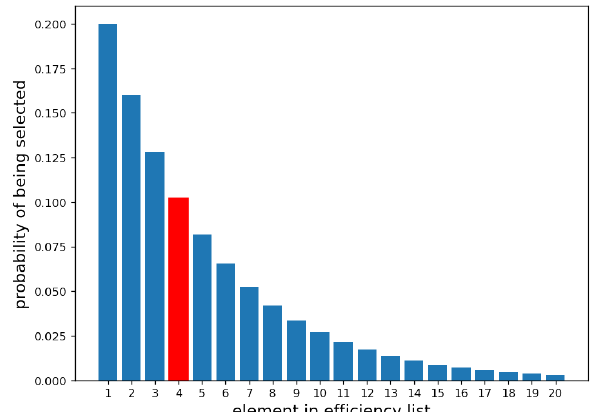
Figure 2. Biased random sampling of elements from a list using a geometric with p = 0.2.